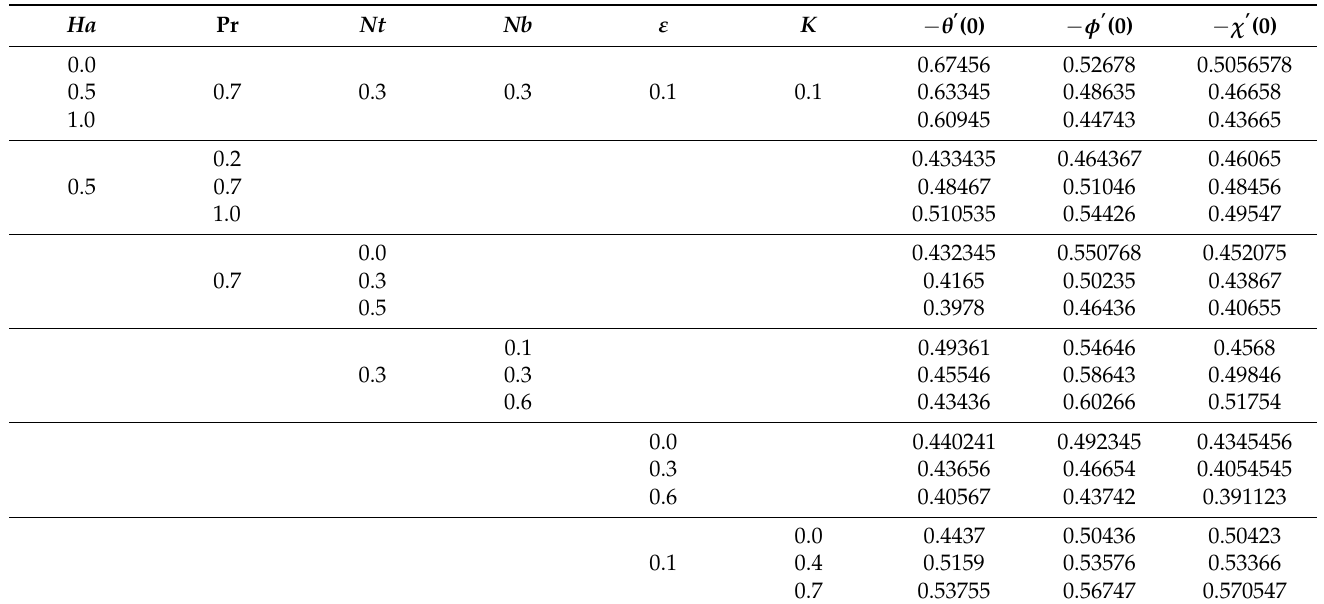
Table 4. Numerical values of local Nusselt number and local Sherwood number when k =